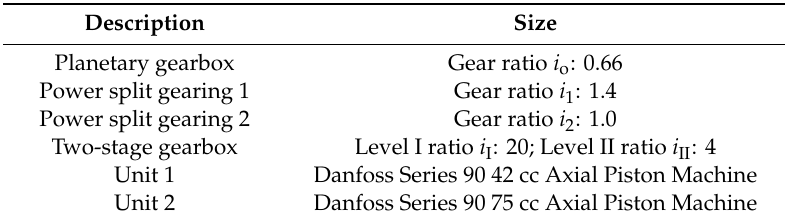
Table 7. Major components of wheel loader